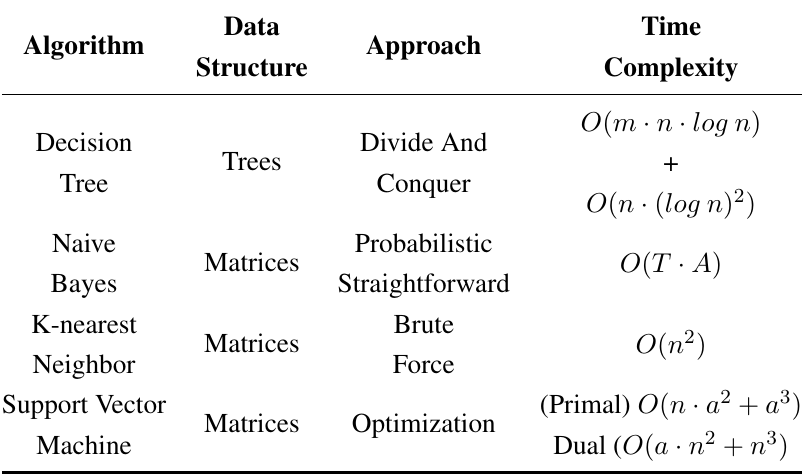
Table 2. Comparison among supervised learning